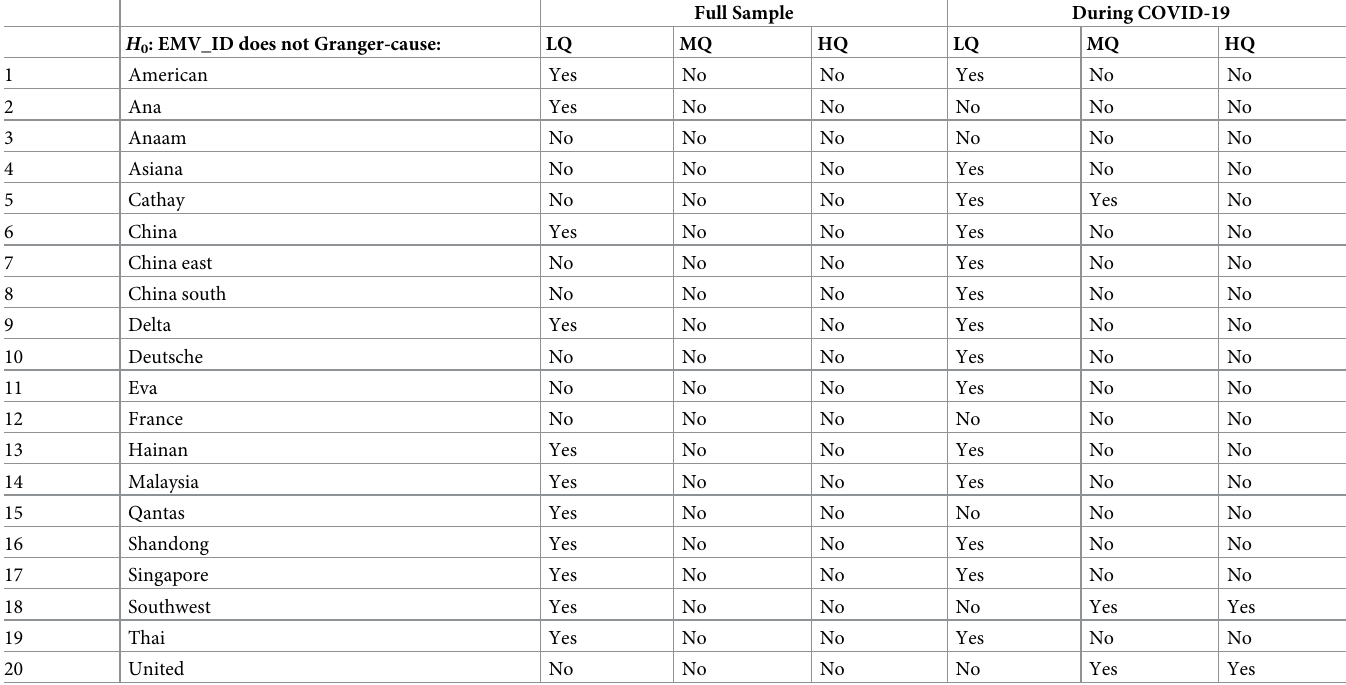
Table 5. Summary of causality in variance (that is, volatility) for both full and during COVID-19